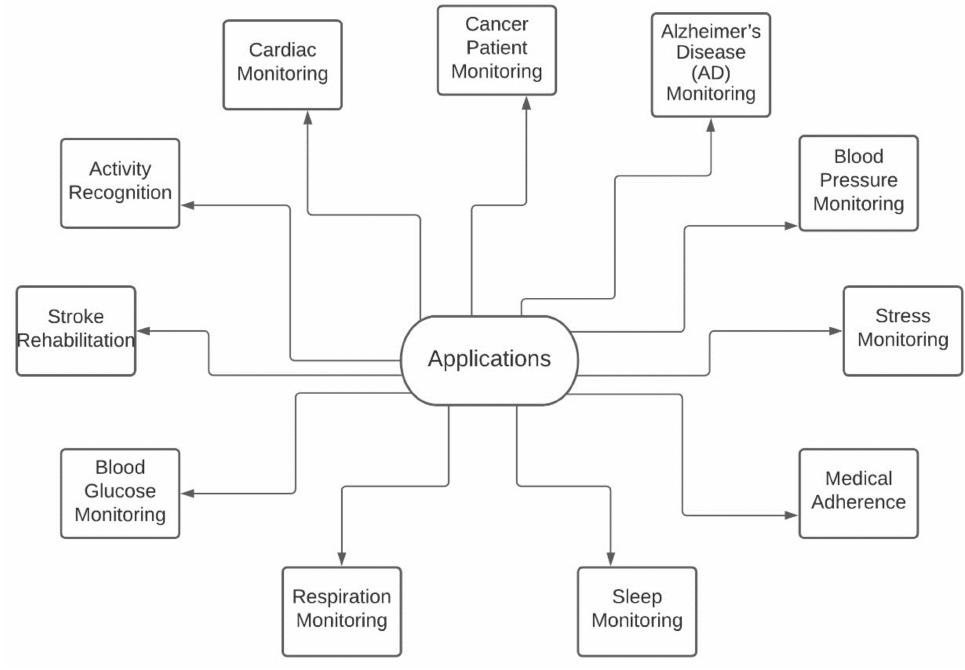
Figure 5. Application of IoT-assisted wearable sensor systems in